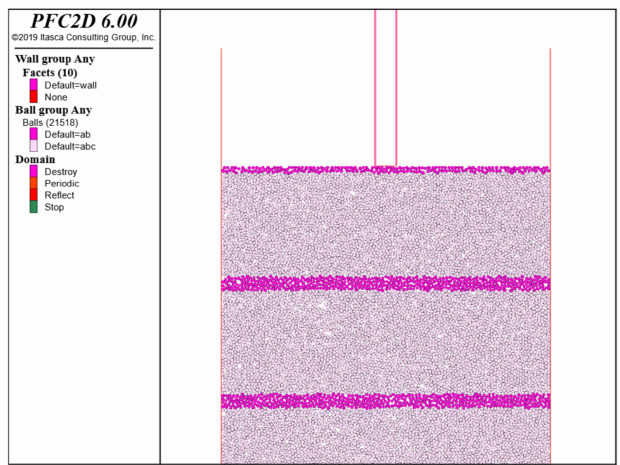
Figure 6. Modeling of soil